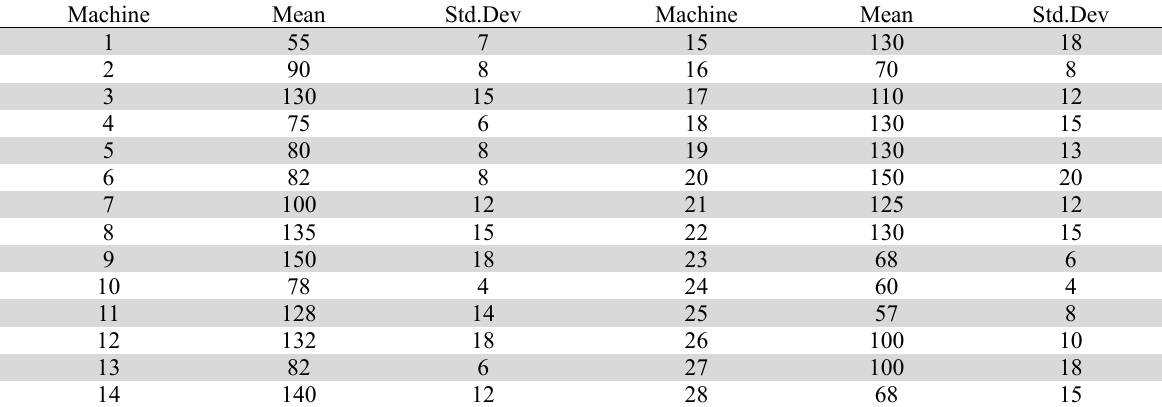
The distributional parameters of processing times for Case 3